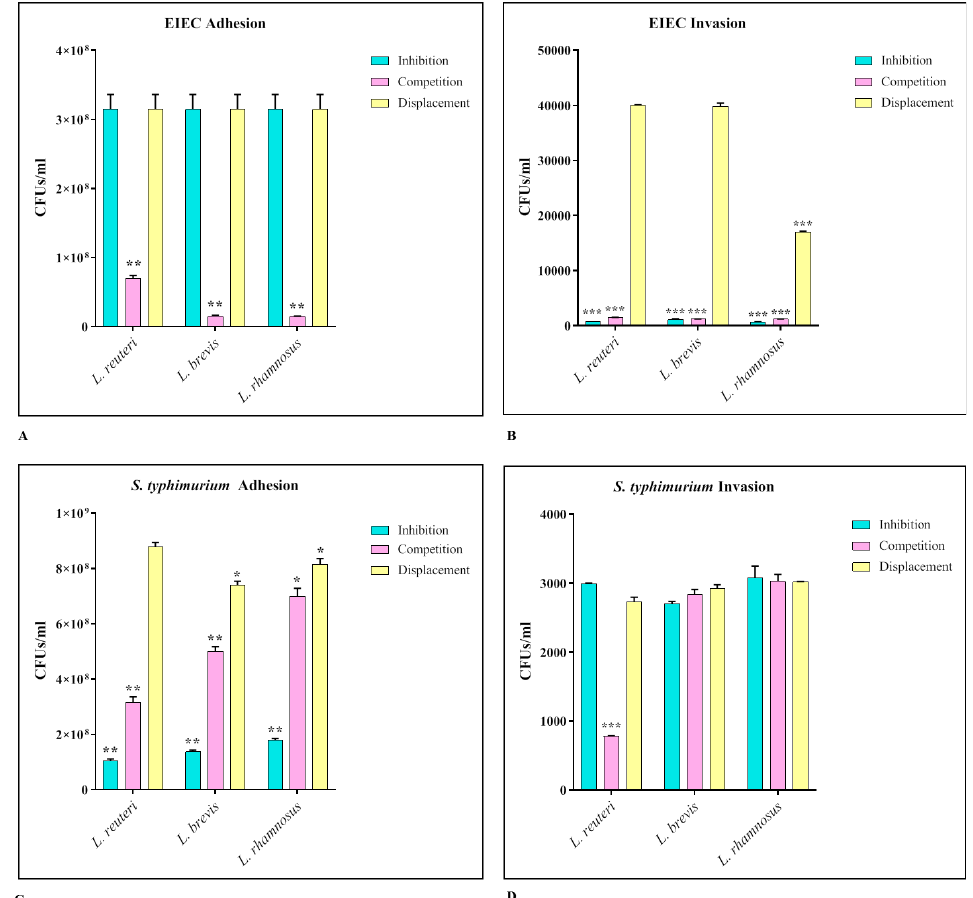
Figure 4. EIEC ( A , B ) and S. Typhimurium ( C , D ) adhesion and invasion assays. The number of live cell-associated bacteria was determined by host cell lysis, plating, and counting of CFUs/mL. The data are representative of three different experiments ± SD. Significant differences are indicated by * p < 0.05, ** p < 0.01, *** p < 0.001.